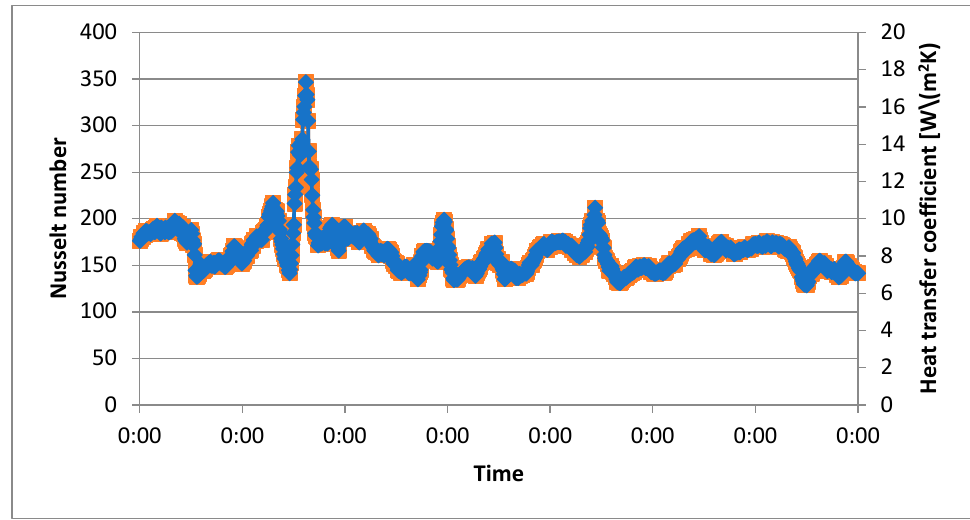
Figure 18. Heat transfer coefficient and Nusselt number on outer surface of the wall 4–10 January. The average heat transfer coefficient throughout the calculation period was 8.31 W/(m 2 K). The minimum value was 6.4 W/(m 2 K), and the maximum was 17.3 W/(m 2 K).